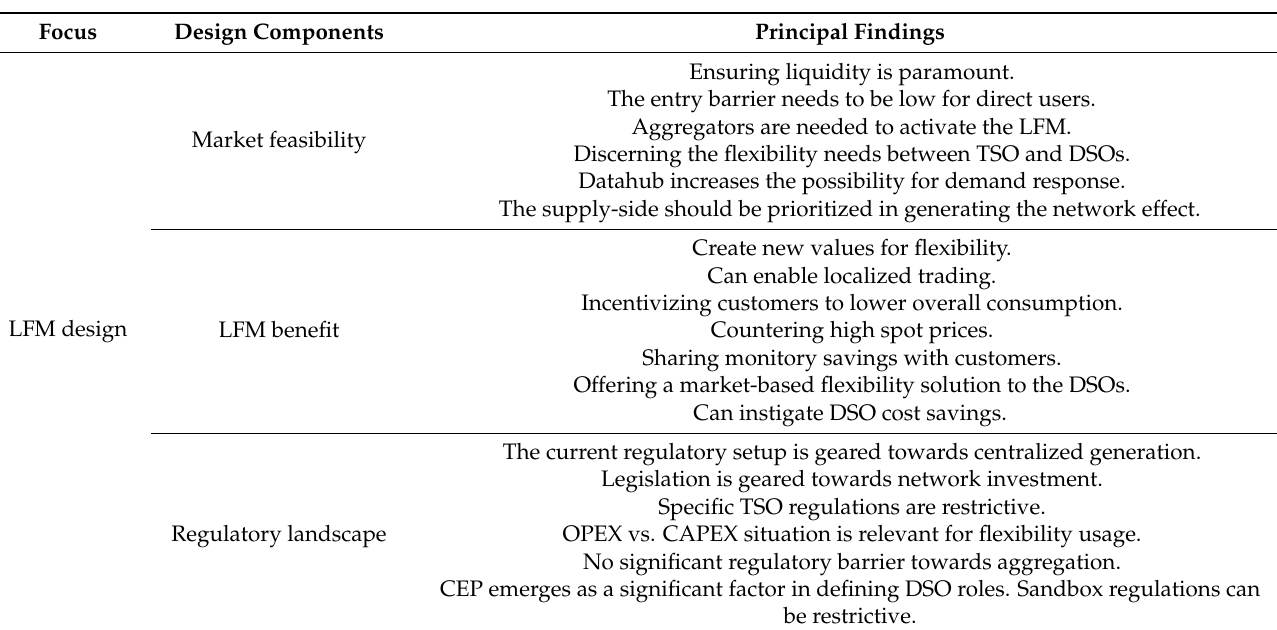
Table 3. Summary of findings on LFM design